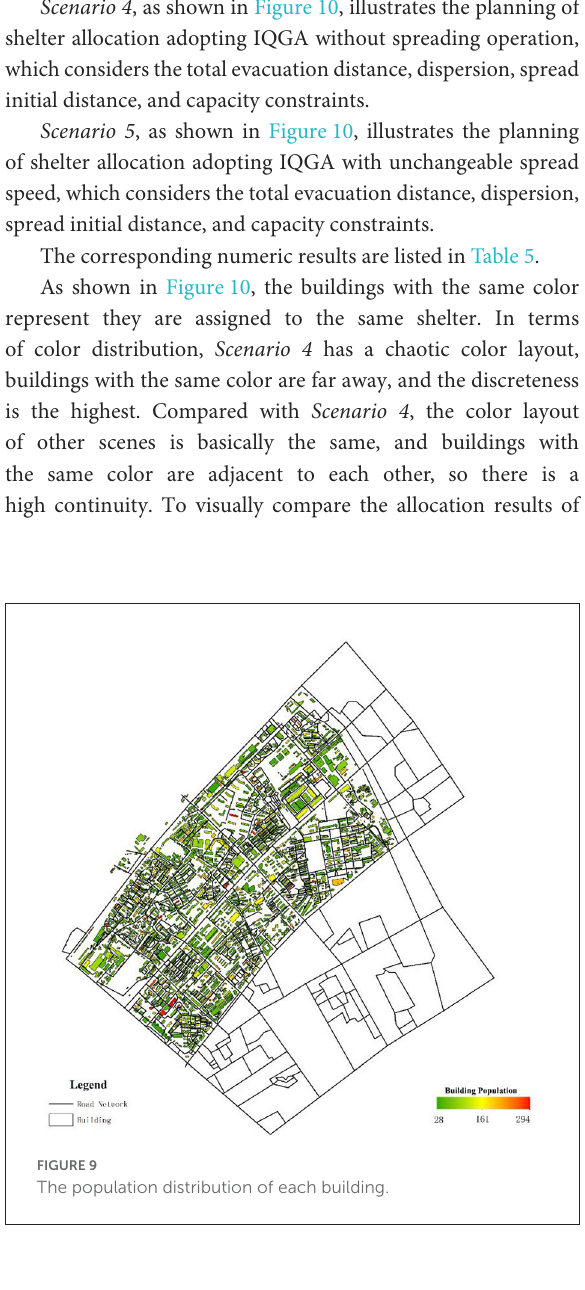
TABLE 4 The capacity of each